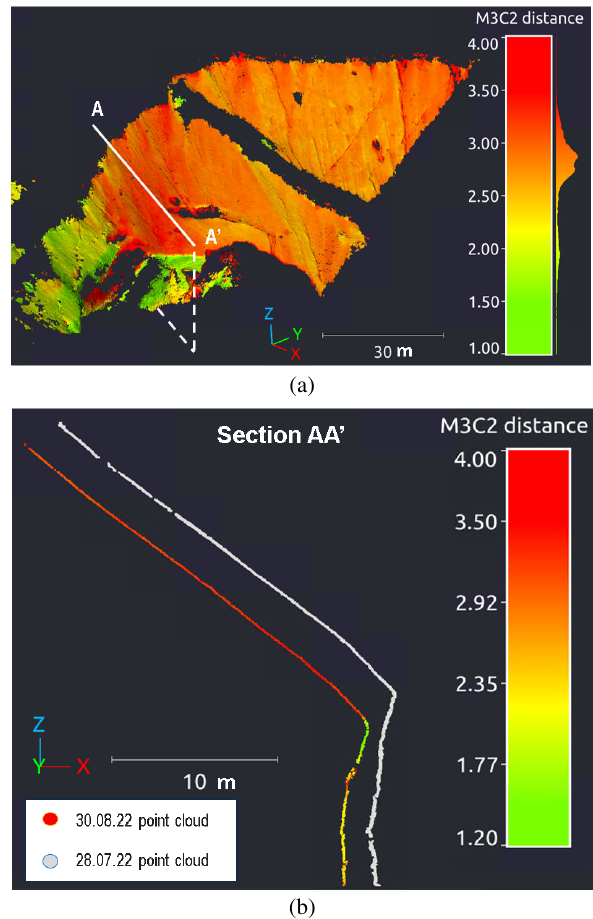
Figure 12. (a) Glacier terminus retreat between 28/07/22 and 30/08/22, computed as M3C2 cloud-to-cloud distances between stereo-point clouds. The colors represent the distances between each point of the 30/08/22 point cloud (seed point) and the points of 28/07/22 that fall within a cylinder oriented as the local normal computed around the seed point. Distances are expressed in meters. (b) Computed distances extracted along the transversal cross-section AA’. The 28/07/22 point cloud is represented with a gray color as a